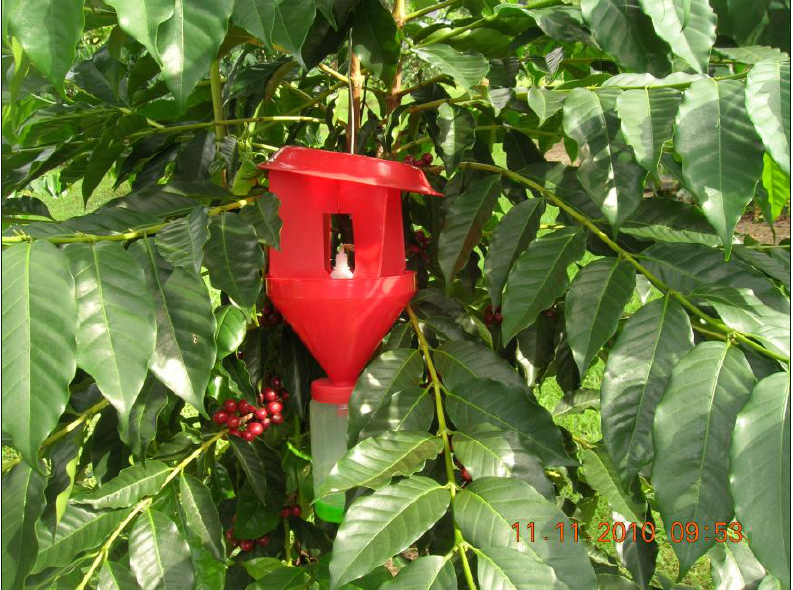
Figure 1. The Brocap trap for the coffee berry